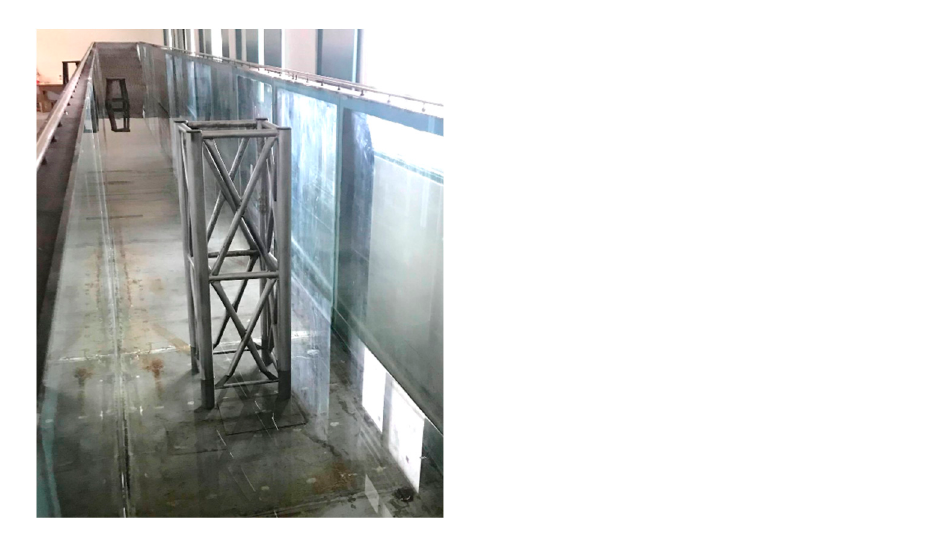
Figure 3. The scaled down testing model in the water tank for the offshore jacket-type